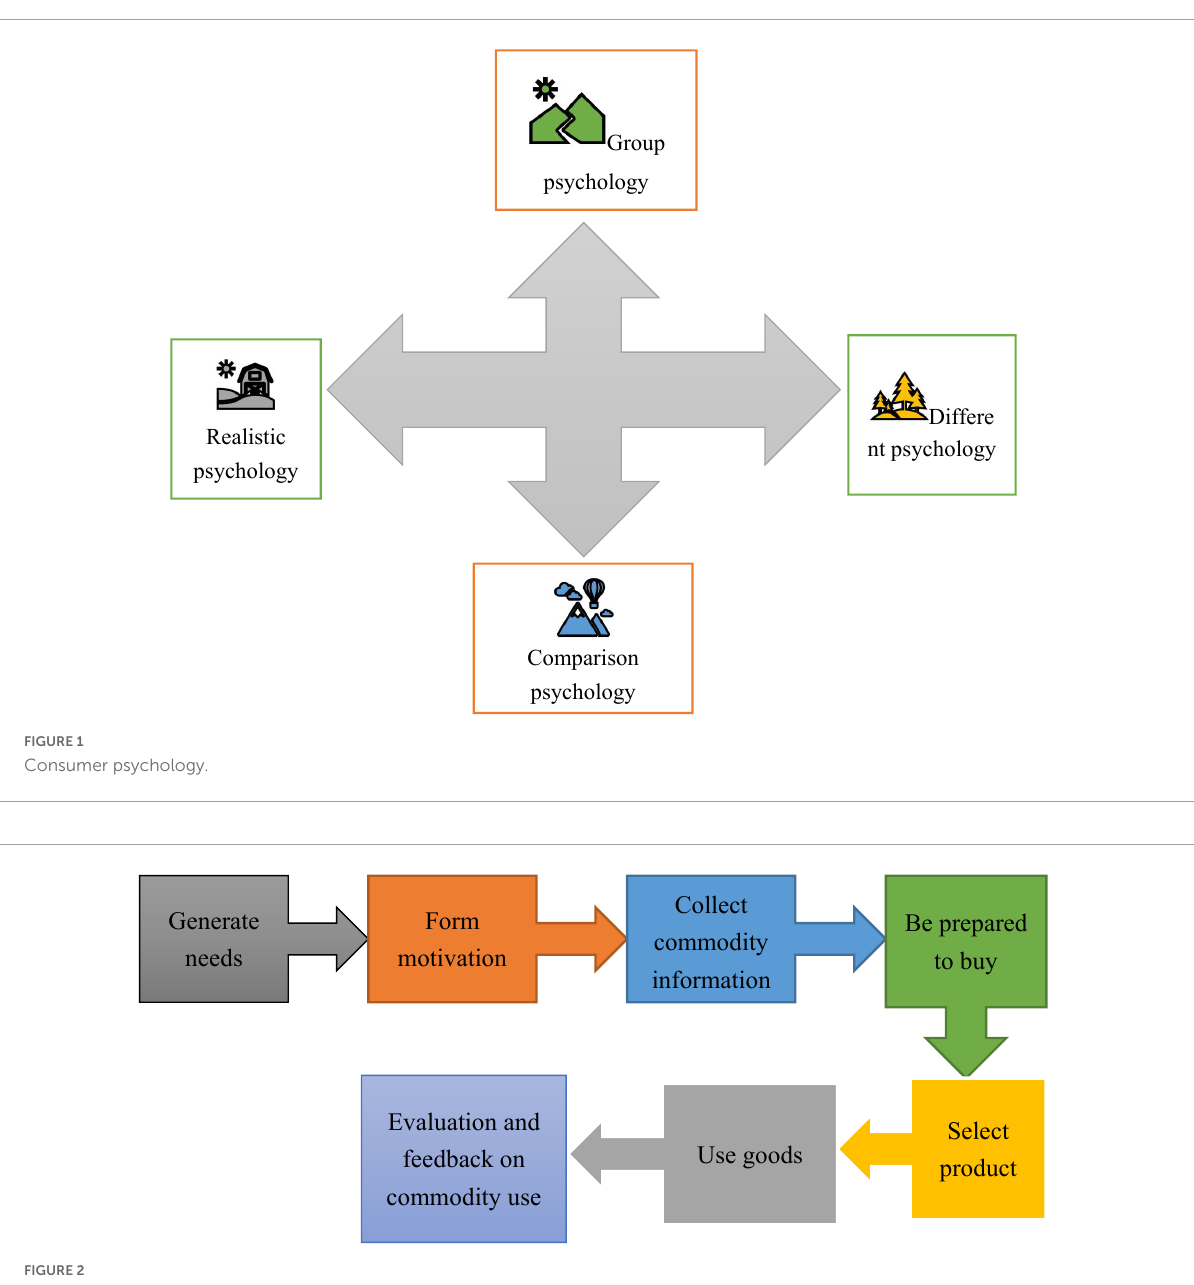
FIGURE2 Consumer psychological